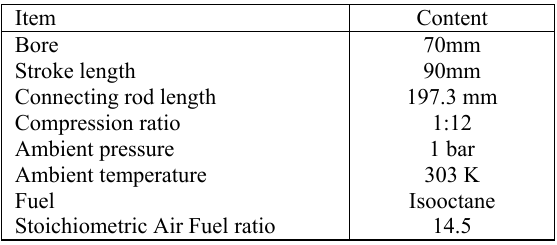
Table 1. Engine geometry parameters used for the